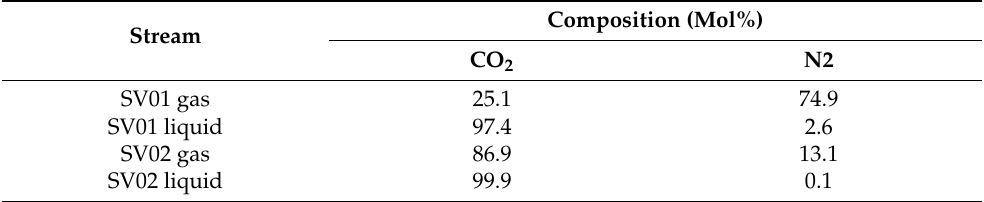
Table 7. GC measurements at the initial state of Experiment